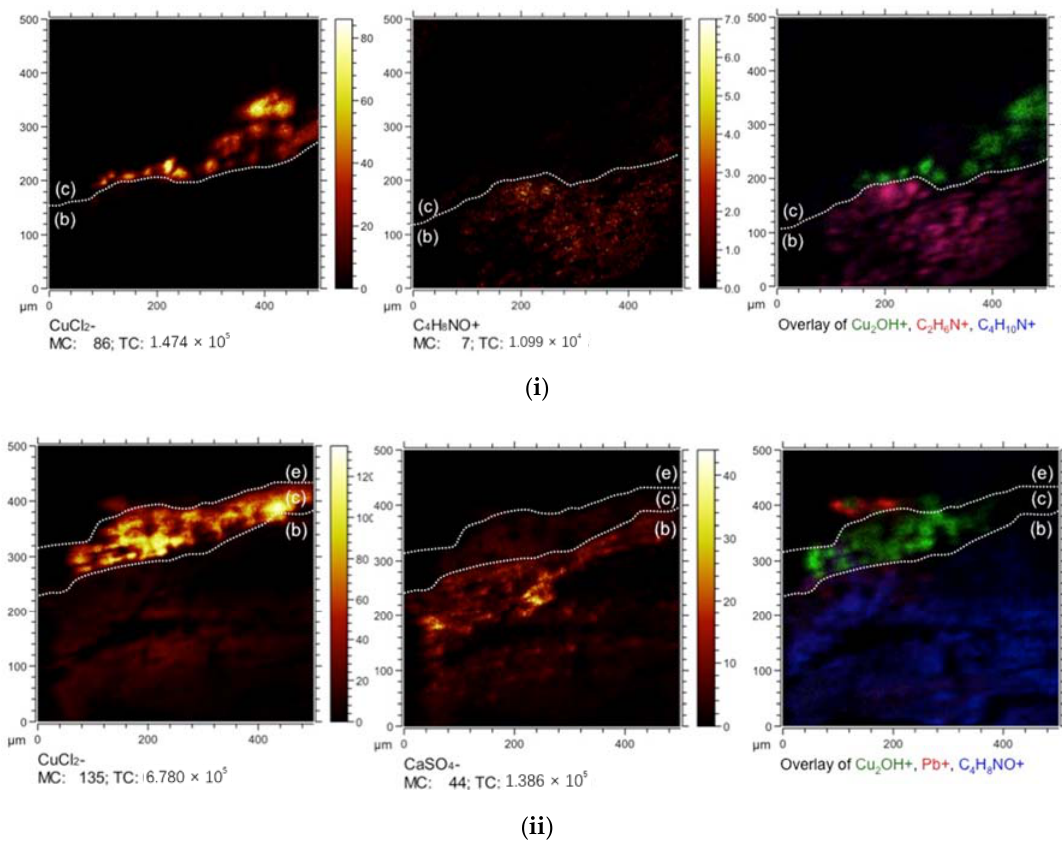
Figure 6. Time of flight-secondary ion mass spectrometry (ToF-SIMS) maps of mass fragments for LXT-04 ( i ) and LXT-05 ( ii